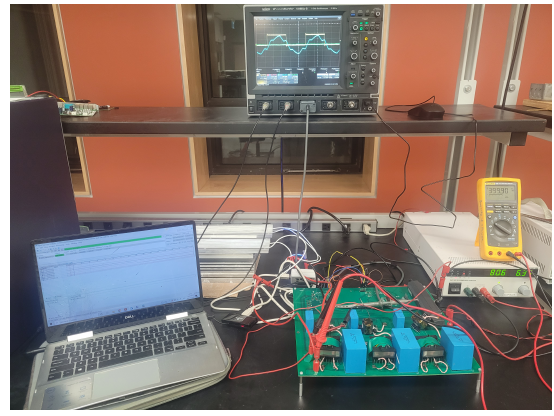
Figure 16. Experimental setup of a 1 kW